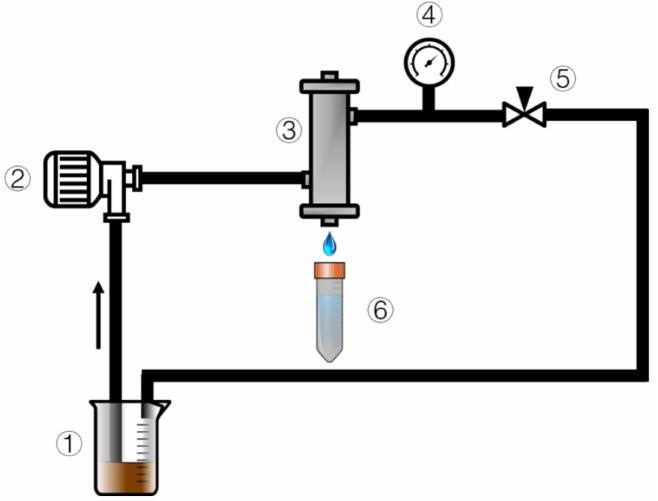
Figure 1. Diagram of the experimental setup of the cross-flow rate: 1 = feed, 2 = pump, 3 = membrane module, 4 = pressure meter, 5 = valve, and 6 =